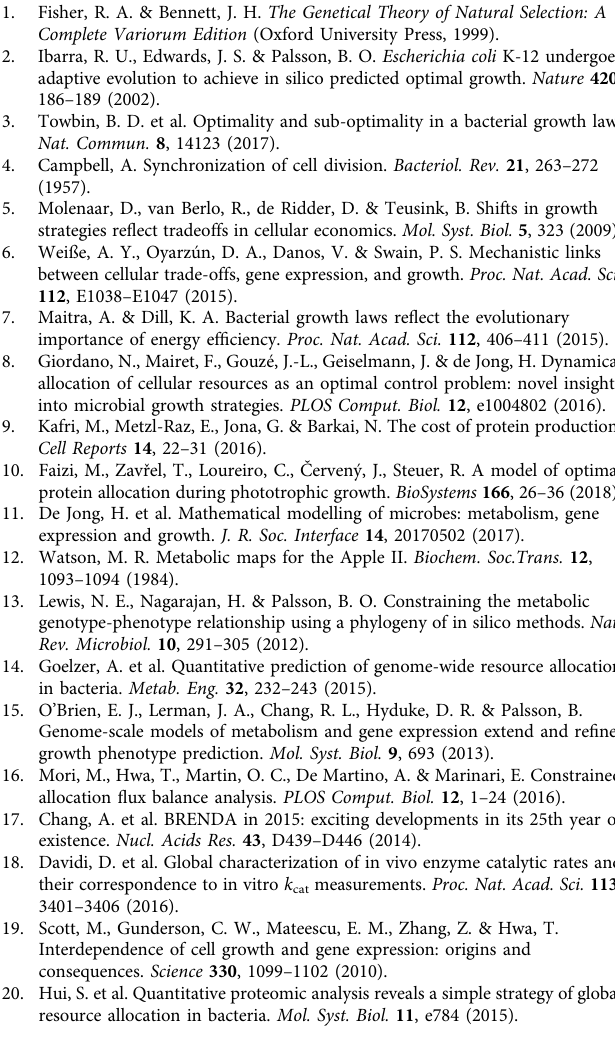
Supplementary Fig. 3 plots the natural logarithms of μ and ρ . Linear regression over the three available data points results in an estimated slope of 0.66, ¼ ρη ρ ¼ 0 : 66. indistinguishable from our estimate of d ln μ (cid:5) d ln ρ Reporting summary . Further information on research design is available in the Nature Research Reporting Summary linked to this